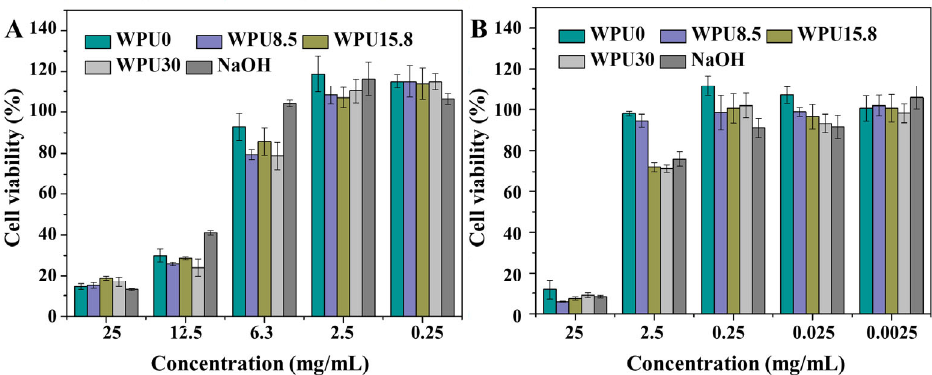
Figure 8. Cell viability of WPUn degradation products with different concentrations after 24 h ( A ) and 72 h ( B ) incubation. Error bars represent means ± standard deviation for n = 3. Statistical significance: p <